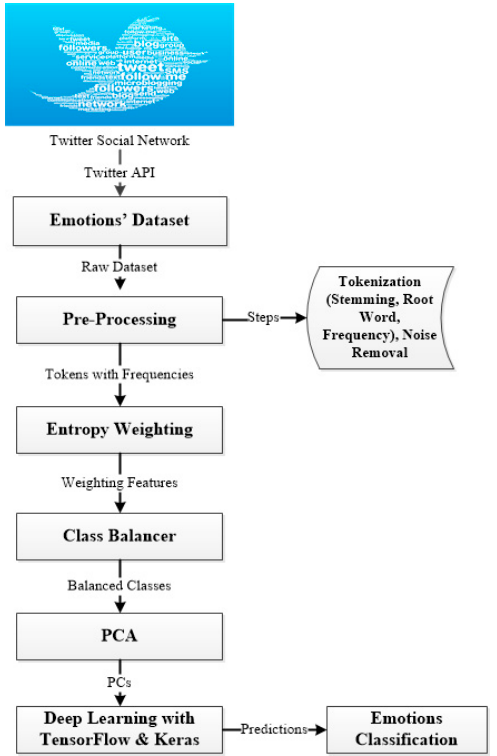
Figure 1. Emotions Classification using a hybrid approach of Deep Learning based on Figure1. EmotionsClassificationusingahybridapproachofDeepLearningbasedonTensorFlow − Keras TensorFlow − Keras and Principal Component Analysis (PCA). and Principal Component Analysis